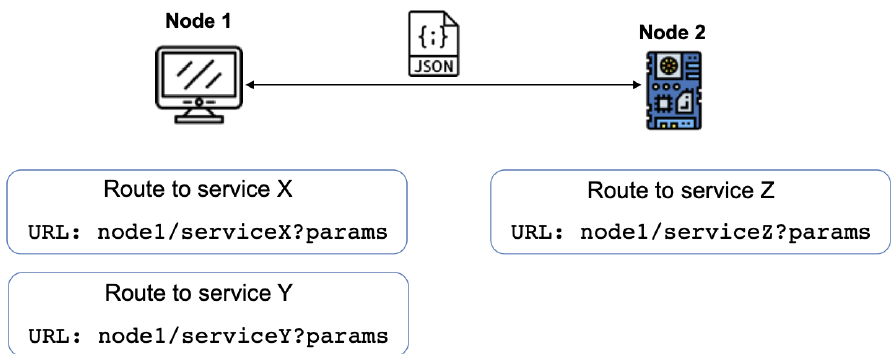
Figure 4. Service-based communication